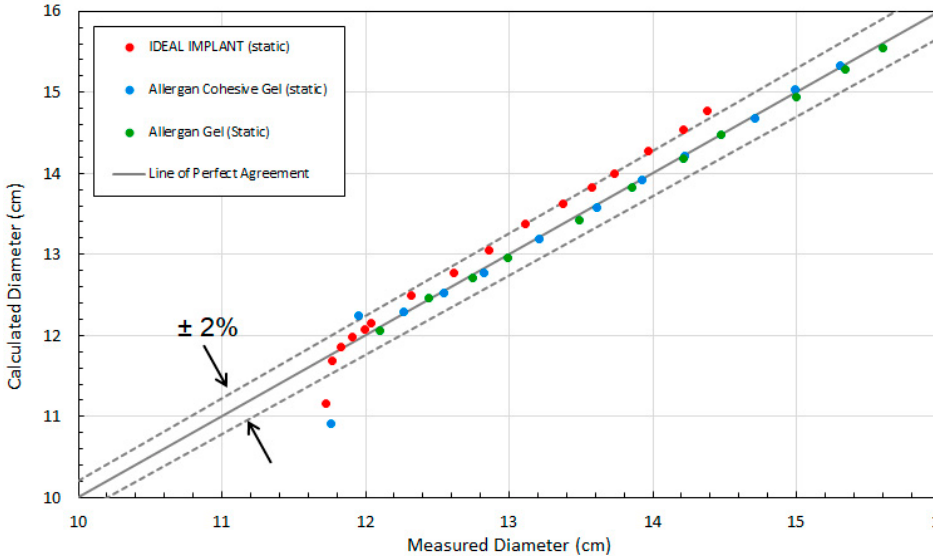
Figure 3. Comparison of Measured and Calculated Diameter (D) for Static Compression Testing.